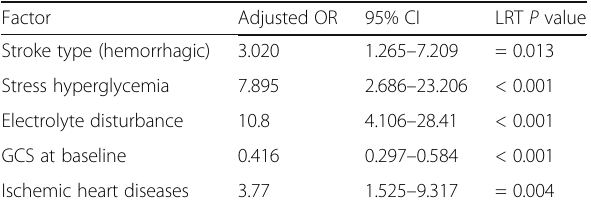
Table 5 Independent correlates of mortality: multivariate regression